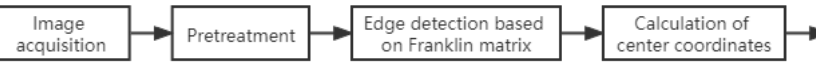
Figure 3. Camera calibration process.